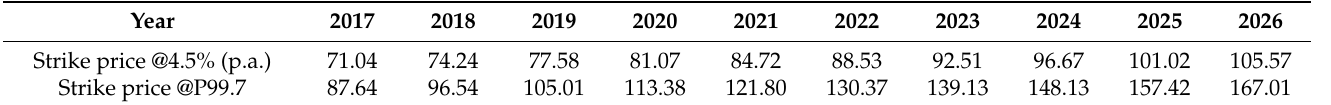
Table 5. Strike prices (INR–USD FX rate) for the FX Hedging Facility